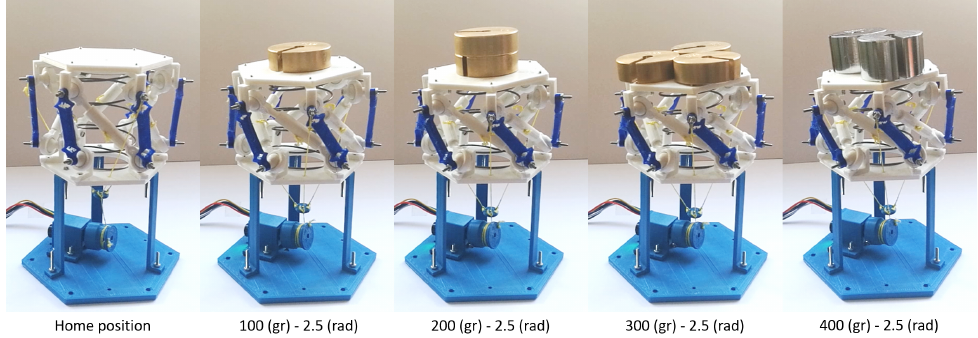
Figure 23. Prototype test results with different payloads in 2.5 (rad)